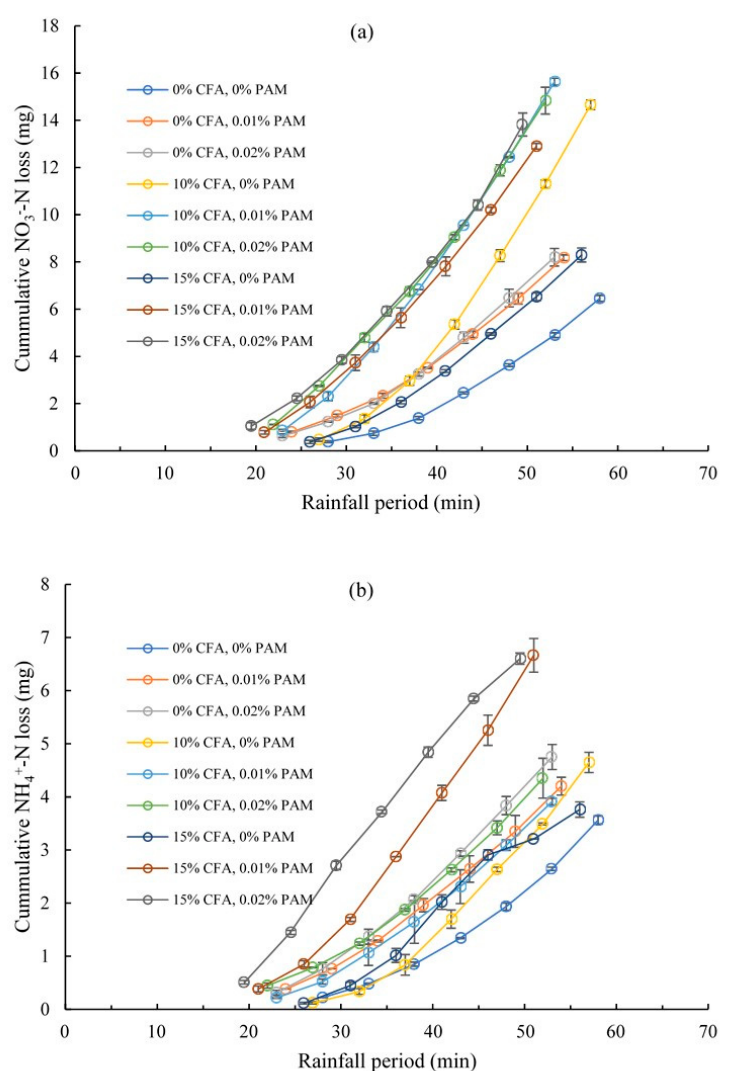
Figure 8. Variations in cumulative NO 3 − -N loss ( a ) and cumulative NH 4+ -N loss ( b ) with runoff for different CFA and PAM treatments. Table 1. Effect of CFA and PAM on runoff-associated cumulative NO 3 − -N and NH 4+ -N losses at the end of the rainfall event.